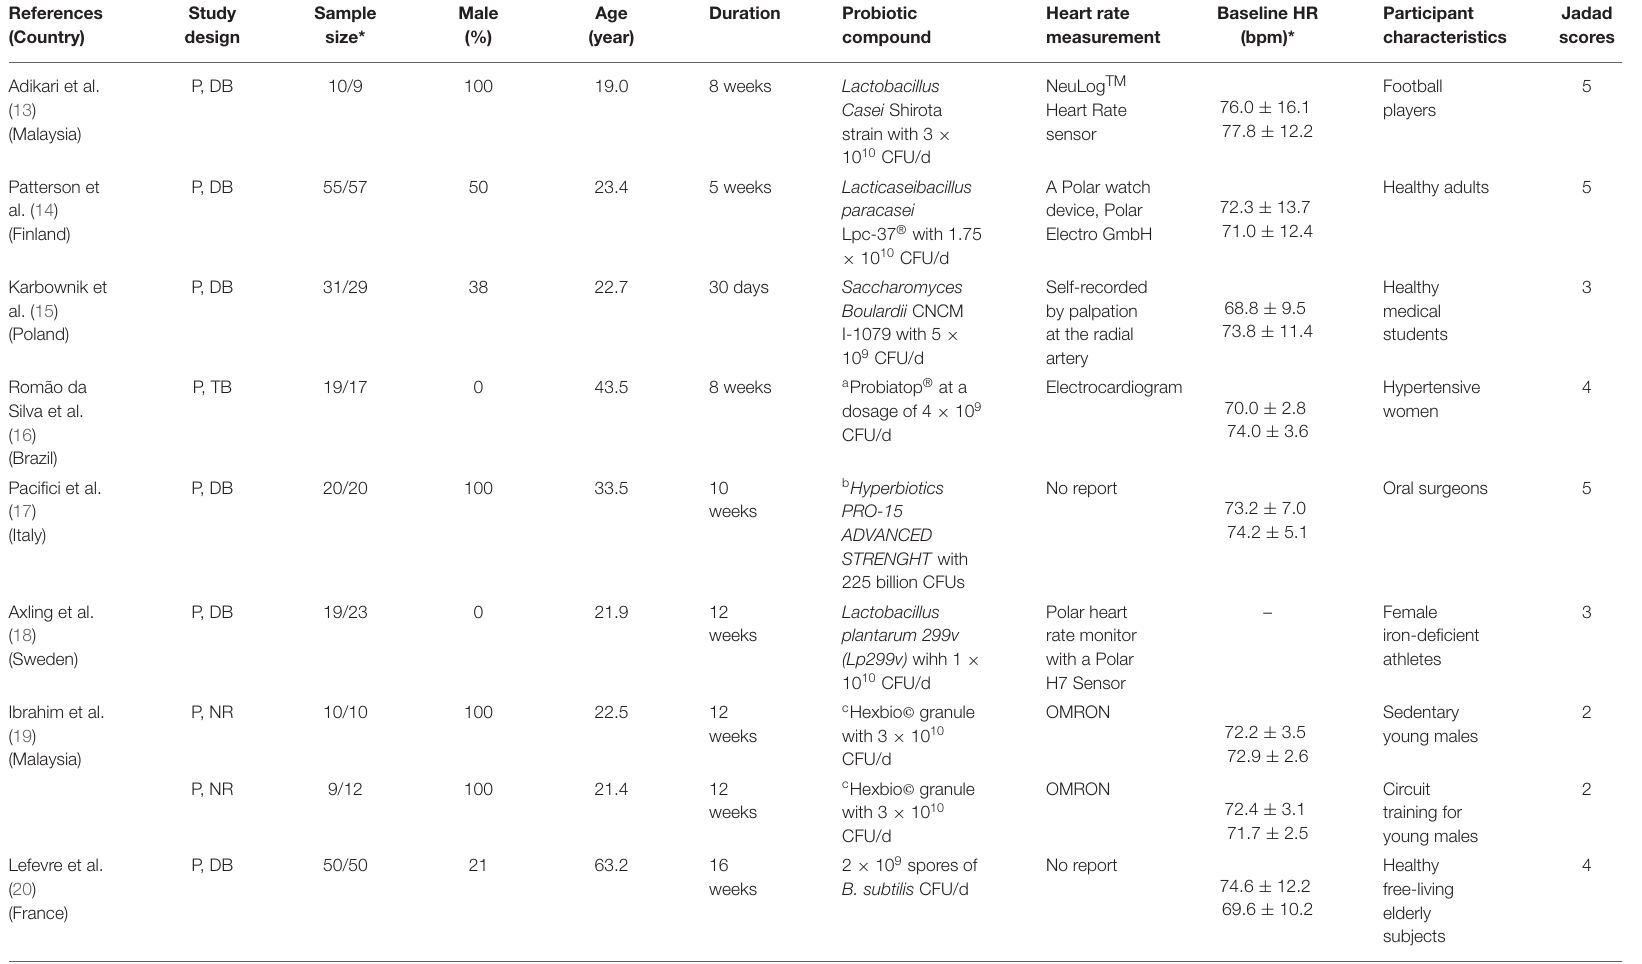
TABLE 1 | Overview and characteristic of the trials and participants in this